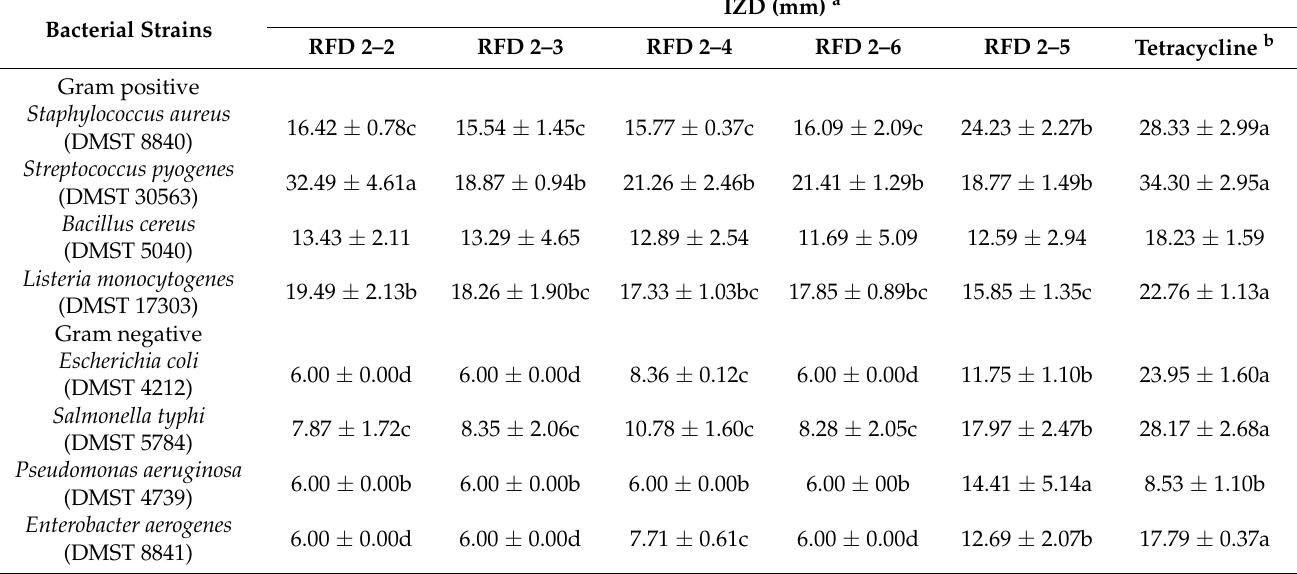
Table 3. The inhibition zone diameters (IZDs) of five eucalypt oil against eight bacterial